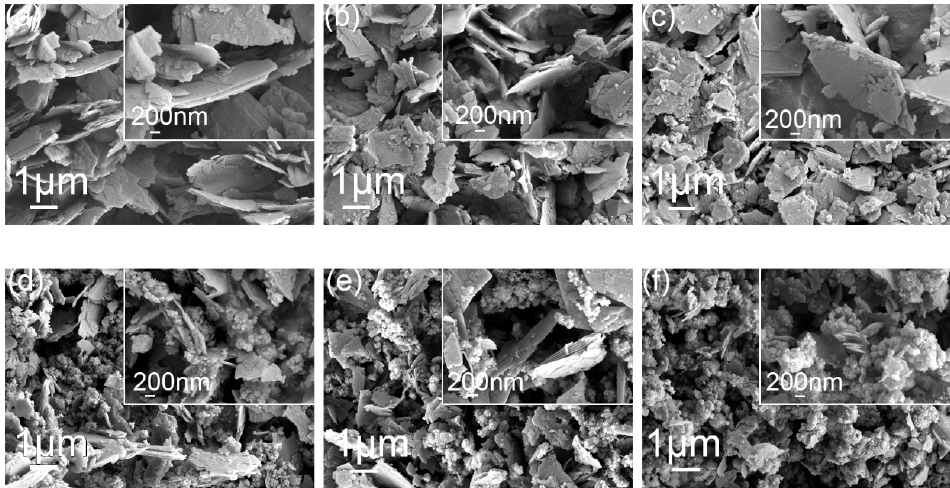
Figure 2. Scanning electron microscope (SEM) images of ( a ) molybdenum sulfide (MoS 2 ) nanosheets; ( b ) MC1; ( c ) MC5; ( d ) MC15; ( e ) MC20; ( f ) MC35.